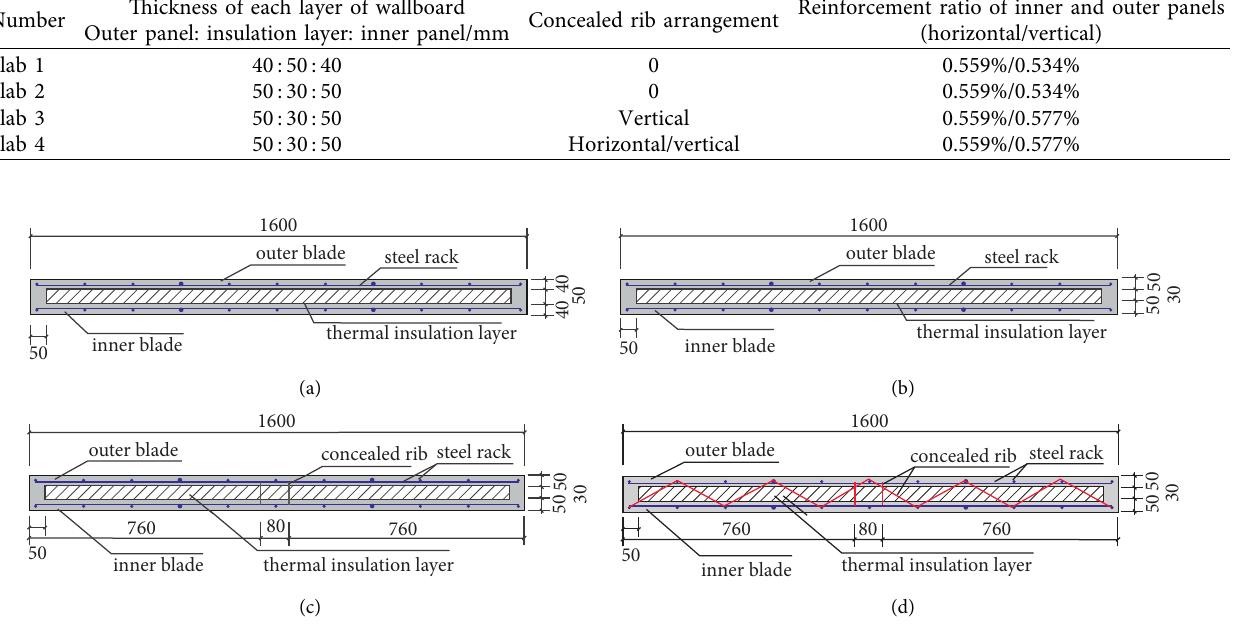
Figure 2: Horizontal section of wallboard: (a) Slab 1; (b) Slab 2; (c) Slab 3; (d) Slab 4.